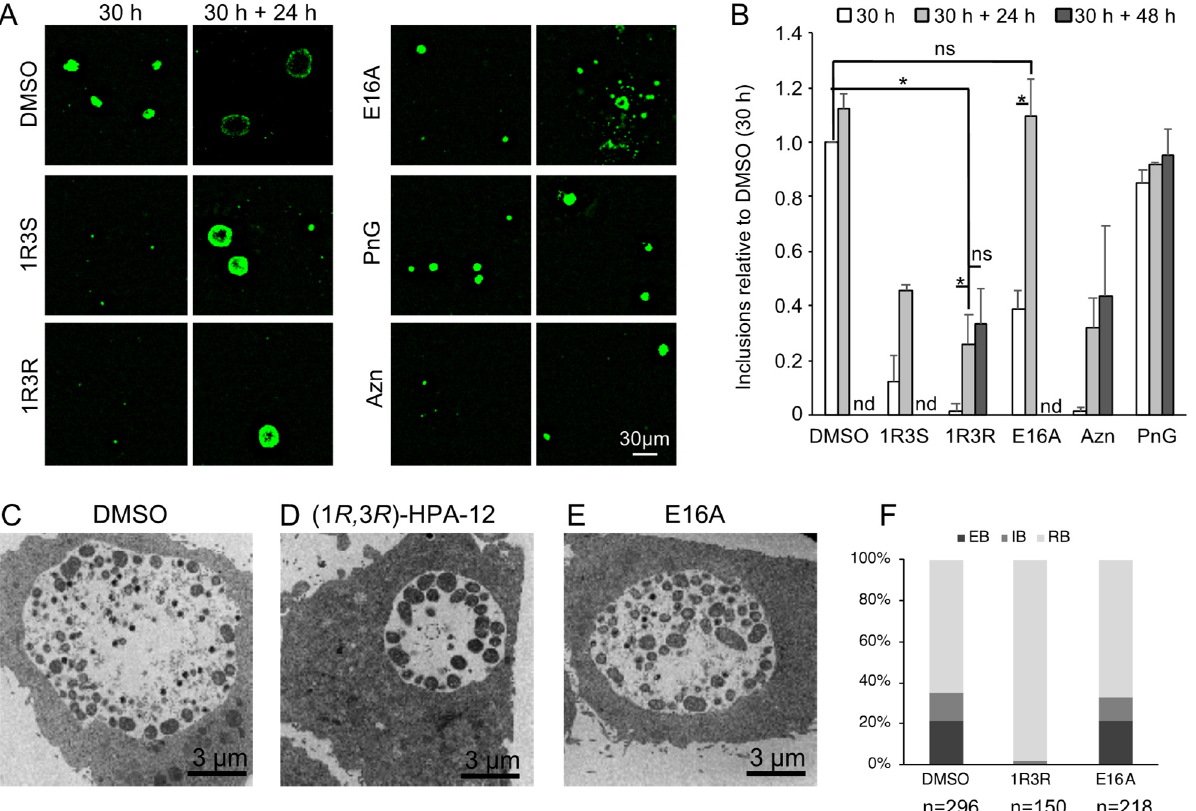
Figure 8. Chlamydial changes induced by treatment with (1 R ,3 R )-HPA-12. ( A , B ) The growth recovery after compound treatment. ( A ) Immunostaining pattern of chlamydia-infected cells. Chlamydia- infected HeLa cells were maintained in DMEM/10% FCS containing 10 µ M of (1 R ,3 S )-HPA-12, 10 µ M of (1 R ,3 R )-HPA-12, 10 µ M of E16A, 330 U/mL penicillin G (PnG), or 5 ng/mL azithromycin for 30 h. The medium was then replaced with DMEM/10% FCS and the cells were maintained for an additional 24 or 48 h. Three independent experiments were performed, and representative fluorescence micrographs are shown. Scale bar, 30 µ m. ( B ) The number of inclusions from compound- treated cells were normalized to that from DMSO-treated cells at 30 h and the mean values ± SD from three experiments are shown. A Student’s t -test with a Bonferroni correction was performed (* p < 0.01; ns, not significant; nd, not determined). ( C – F ) TEM analysis of chlamydial inclusions. Chlamydia-infected HeLa cells were maintained in DMEM/10% FCS in the presence of ( C ) DMSO, ( D ) 5 µ M of (1 R ,3 R )-HPA-12, or ( E ) 5 µ M of E16A for 30 h followed by fixation for TEM analysis. Scale bar, 3 μ m. ( F ) Distribution of the developmental phase of C. trachomatis . The chlamydial particles classified as an elementary body (EB), a reticulate body (RB), and an intermediate body (IB) were counted and are shown as percentages of the total counts. The data are representative of two independent experiments.